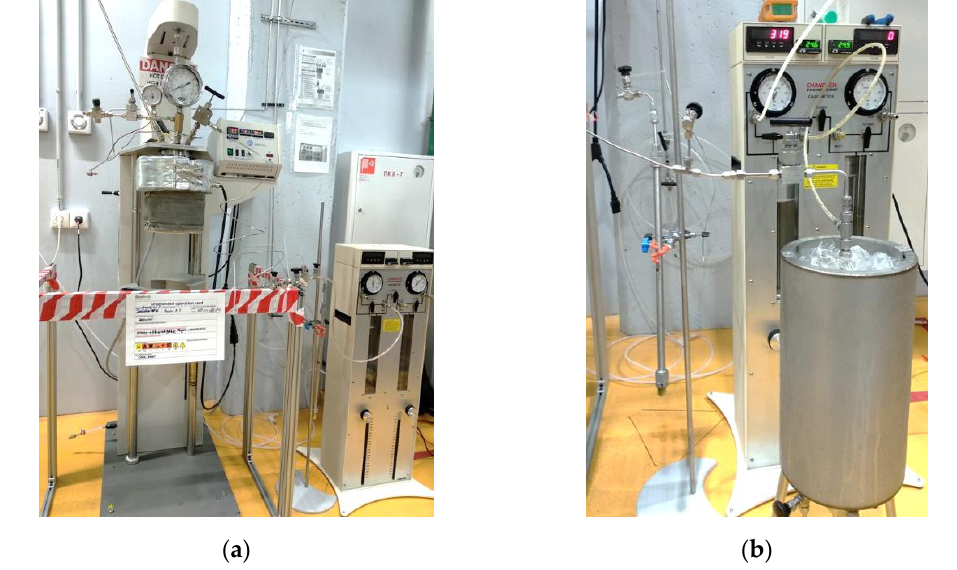
Figure 1. ( a ) The appearance of autoclave installation and ( b ) sampling system used in experiments.